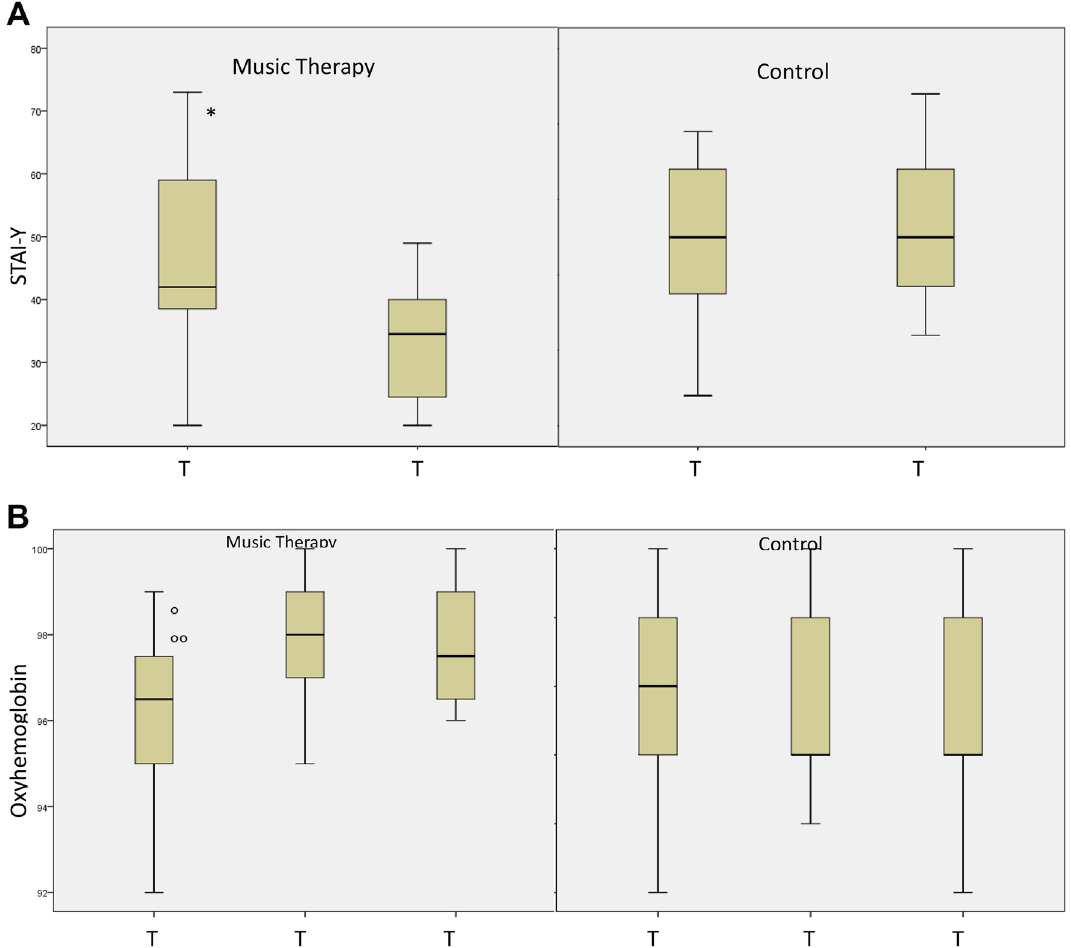
Figure 1. Comparison box plot at different times of the MG and of the CG for the STAI-Y parameters and percentage of Oxyhemoglobin Saturation. STAI-Y1 State-Trait Anxiety Inventory—y form, TO time at the start of the session, T1 time during the session, T2 time at the end of the session. (A) Comparison between time T2 and time T0 of the STAI-Y score respectively within the music therapy group and in the control group.